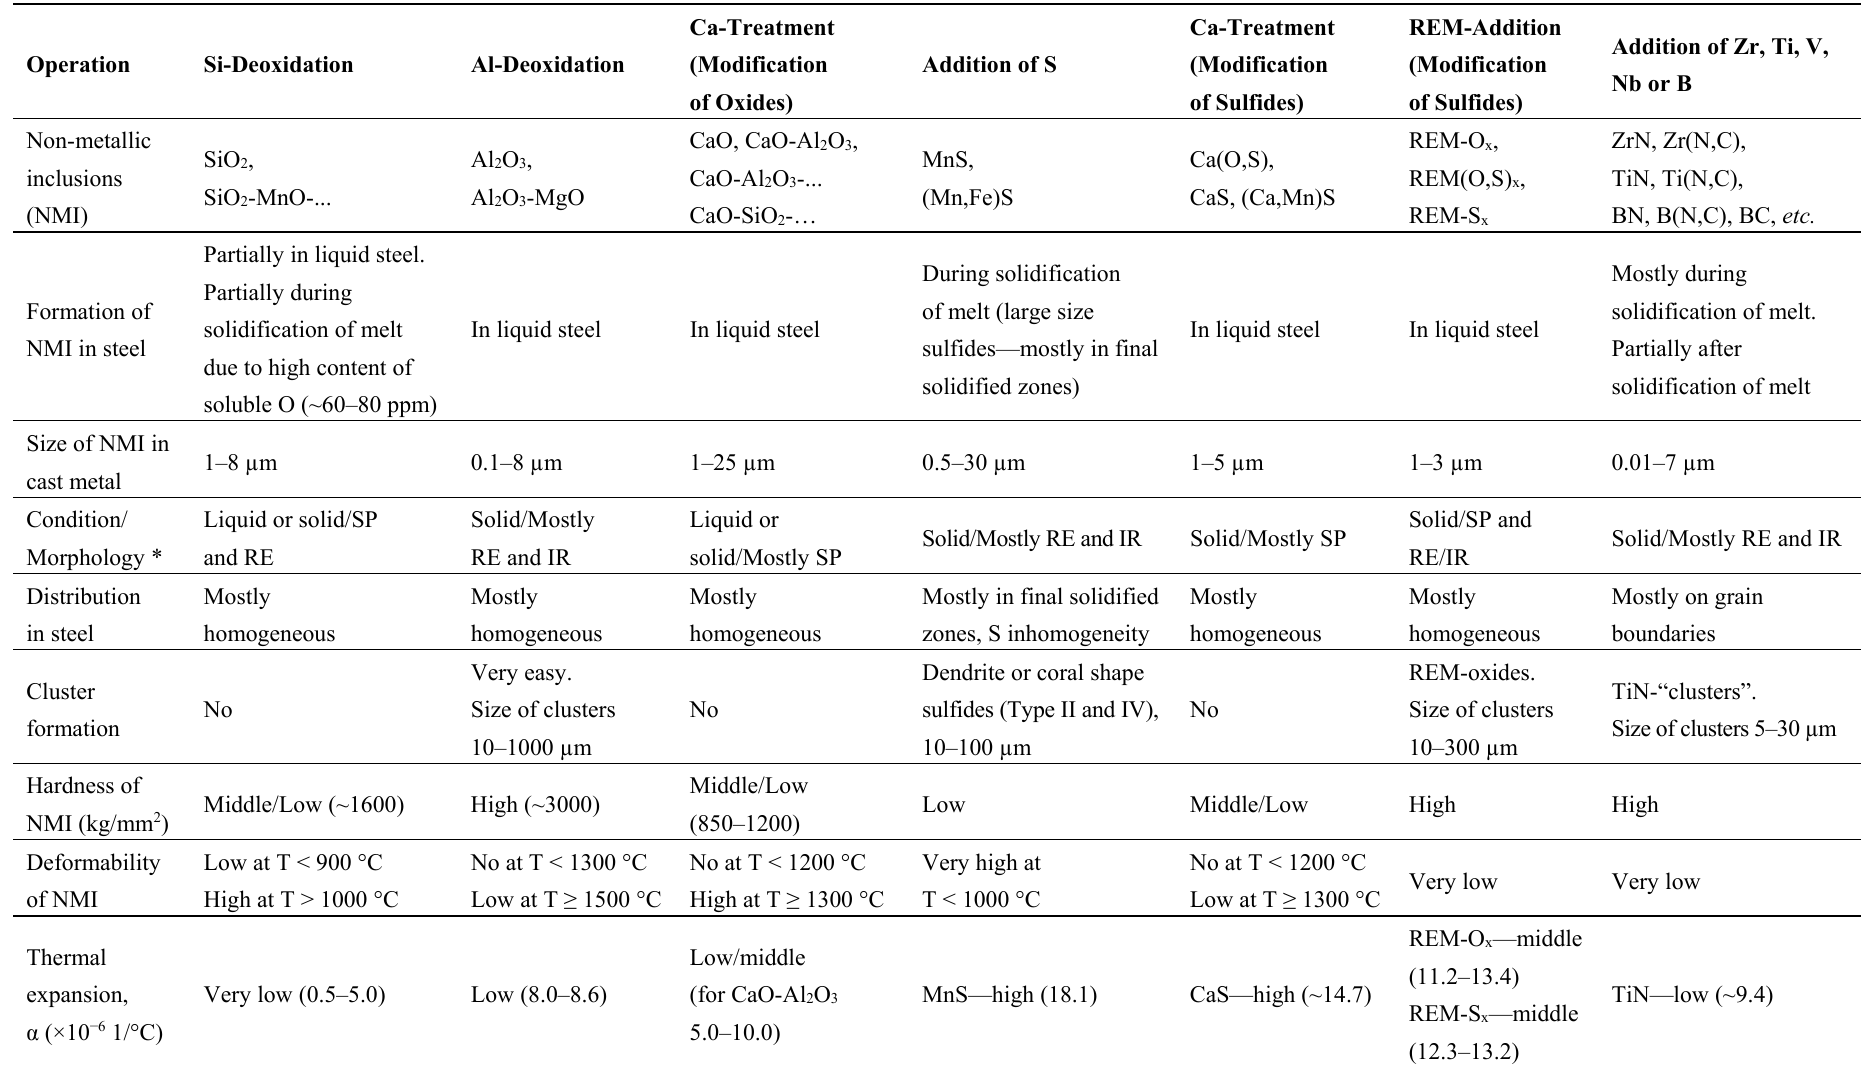
Table 2. Comparative characteristics of different non-metallic inclusions in